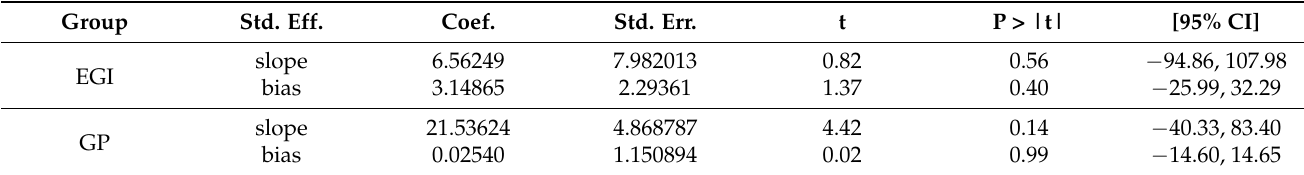
Table 4. Egger’s test of EGI, GP, and SDS